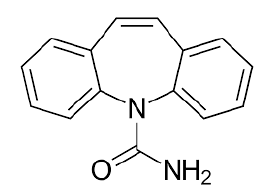
Figure 8. The structure of Carbamazepine.